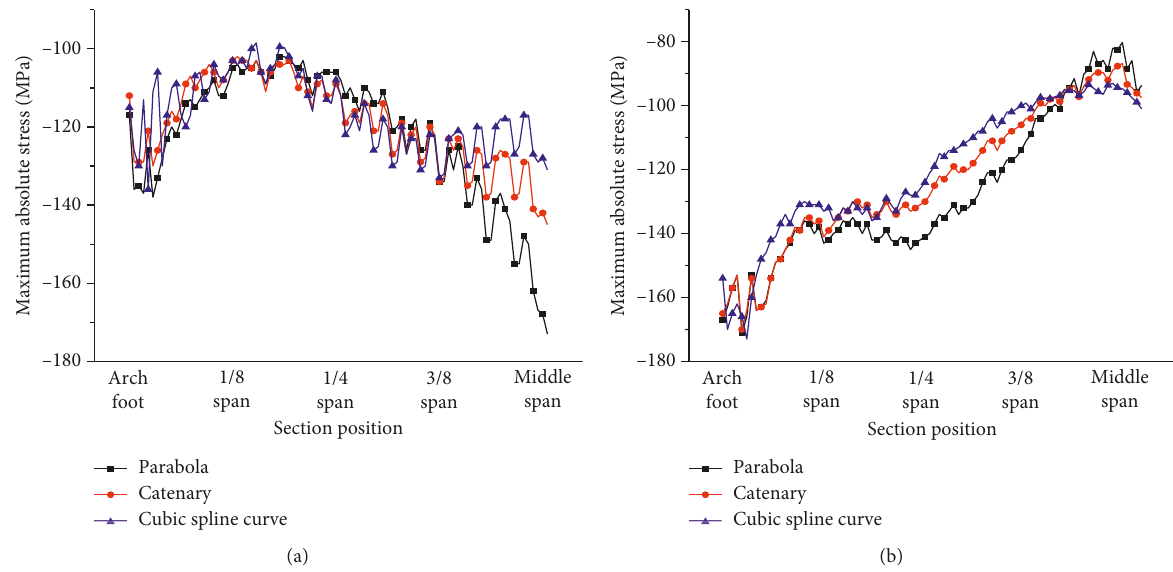
Figure 11: Stress distribution of the main arch rib of the half-bridge. (a) Stress distribution of the upper chord. (b) Stress distribution of the lower chord.